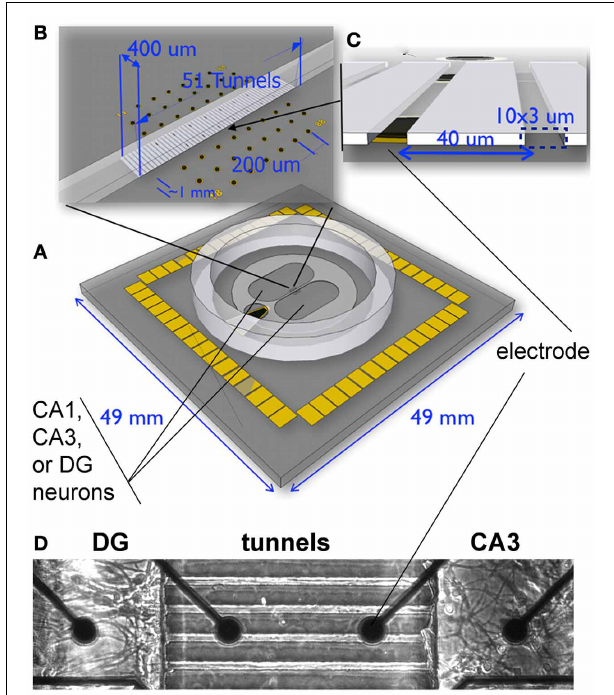
FIGURE 1 | Experimental system for reconstruction of hippocampal sub-regional circuits on multi-electrode array. (A) Dual culture chamber on microelectrode array separated by microtunnels. Note ground electrode on lower left for common culture medium, (B) 51 tunnels of 400um length aligned to the 8 columns of electrodes. (C) Fifty-one tunnels of 3 × 10um cross section were separated by 40um with alignment over one pair of dark electrodes shown. (D) Phase contrast imaging of live neurons shows how the tunnels promoted selective growth of axons from one compartment into